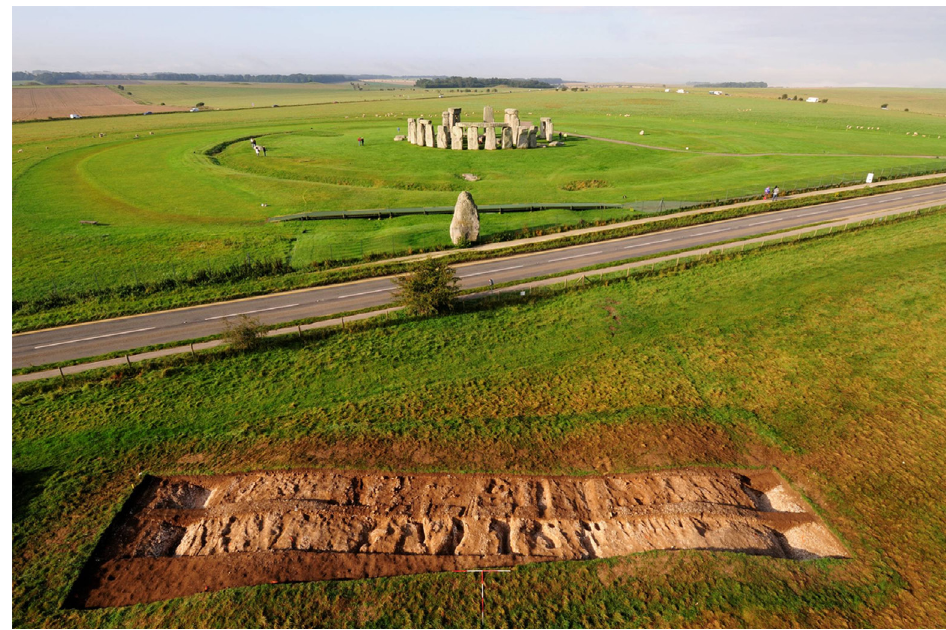
Fig. 6: Excavation of the Stonehenge Avenue in 2008 (photo: Adam